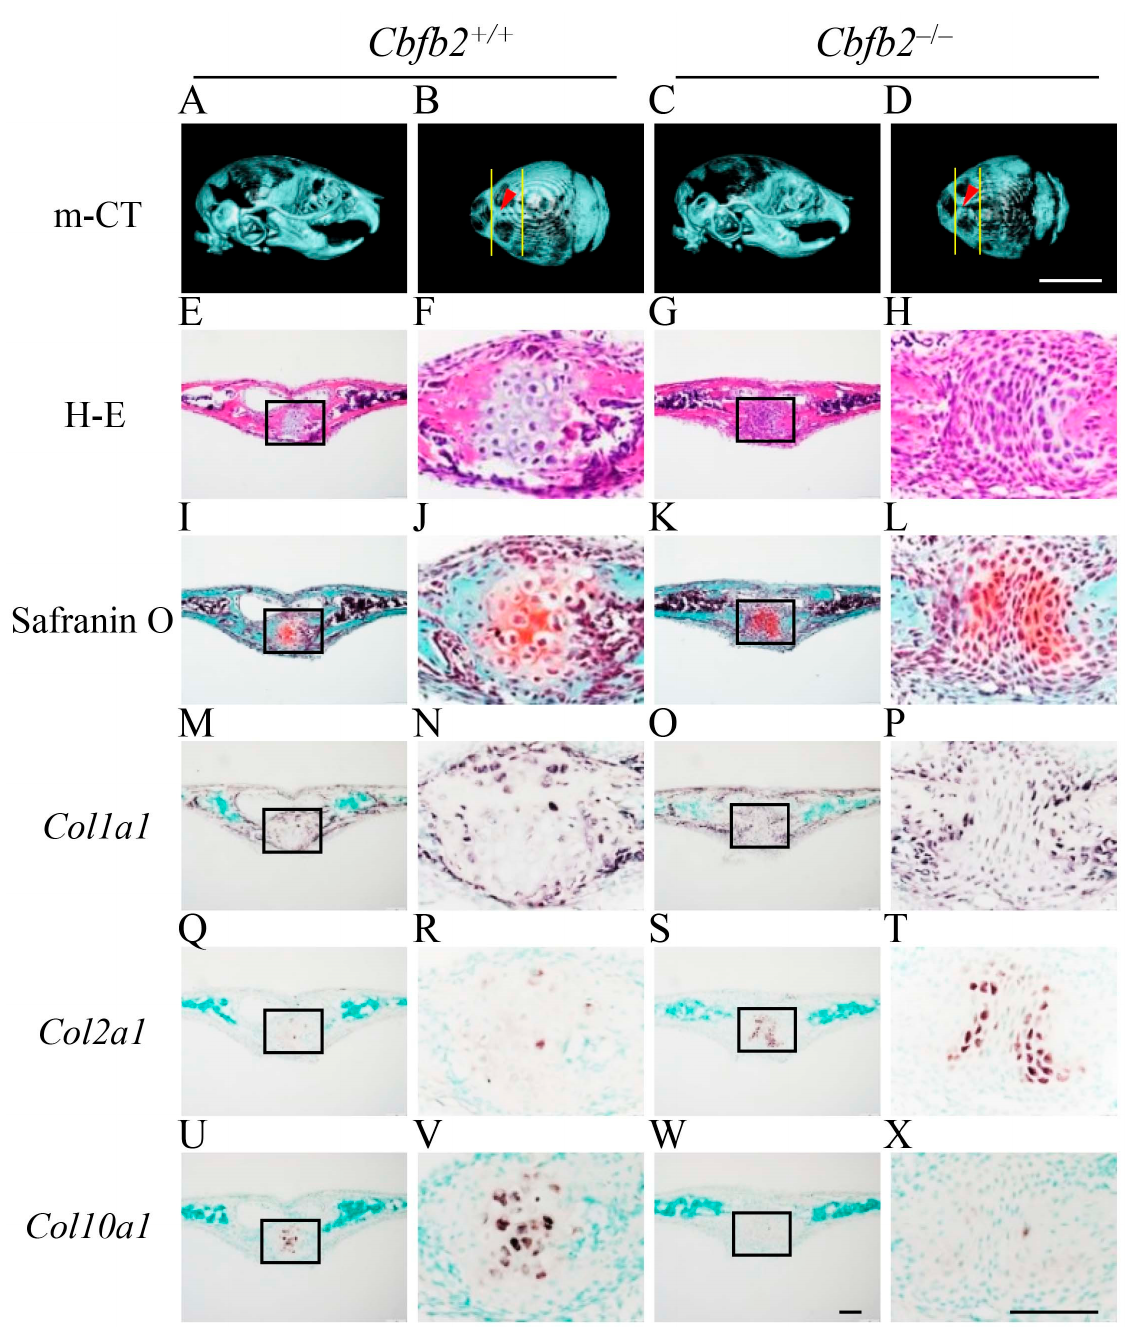
Figure 5. Micro ‐ CT and histological analyses of posterior frontal sutures in Cbfb2 +/+ and Cbfb2 –/– mice at P10. ( A – D ) Lateral ( A , C ) and dorsal ( B , D ) views of micro ‐ CT images of skulls. The two lines in ( B ) and ( D ) show the anterior and posterior boundaries of the posterior frontal suture, and arrow heads indicate the location of coronal sections in the histological analyses. ( E – H ) H-E staining. ( I – L ) Safranin O staining. ( M – X ) In-situ hybridization using a Col1a1 ( M – P ), Col2a1 ( Q – T ) and Col10a1 ( U – X ) probes. The boxed regions in the left columns were magnified in the right columns. In-situ hybridization using the sense probes showed no significant signals. Scale bars: 0.5 cm ( A – D ) and 100 µ m ( E – X ). Three Cbfb2 +/+ mice and two Cbfb2 − / − mice were analyzed.